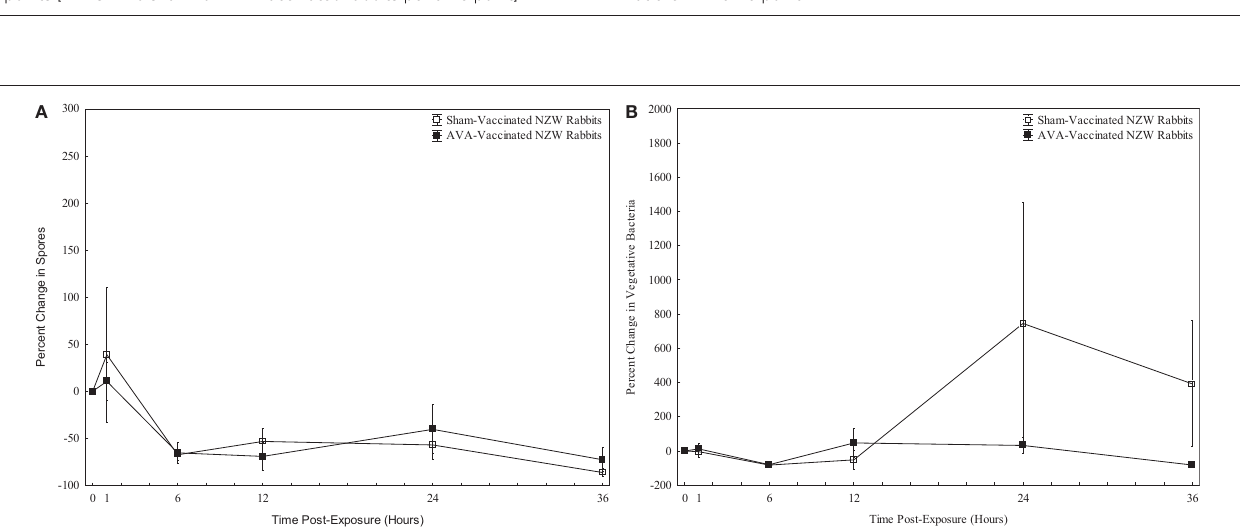
For (B) , n = 5 for the 1, 6, and 12h groups and between 8–10 for the 24 and 36h time points. Macrophage numbers at the zero time point are from five non-treated, age-matched and weight-matched control rabbits. All data are mean ± SEM. In (B) , at 24h, BAL from sham-vaccinated rabbits had significantly less macrophages: ∗ p = 0 . 004 compared to sham-vaccinated time zero animals and ∗∗ p = 0 . 005 compared to AVA-vaccinated rabbits at the 24h time point.